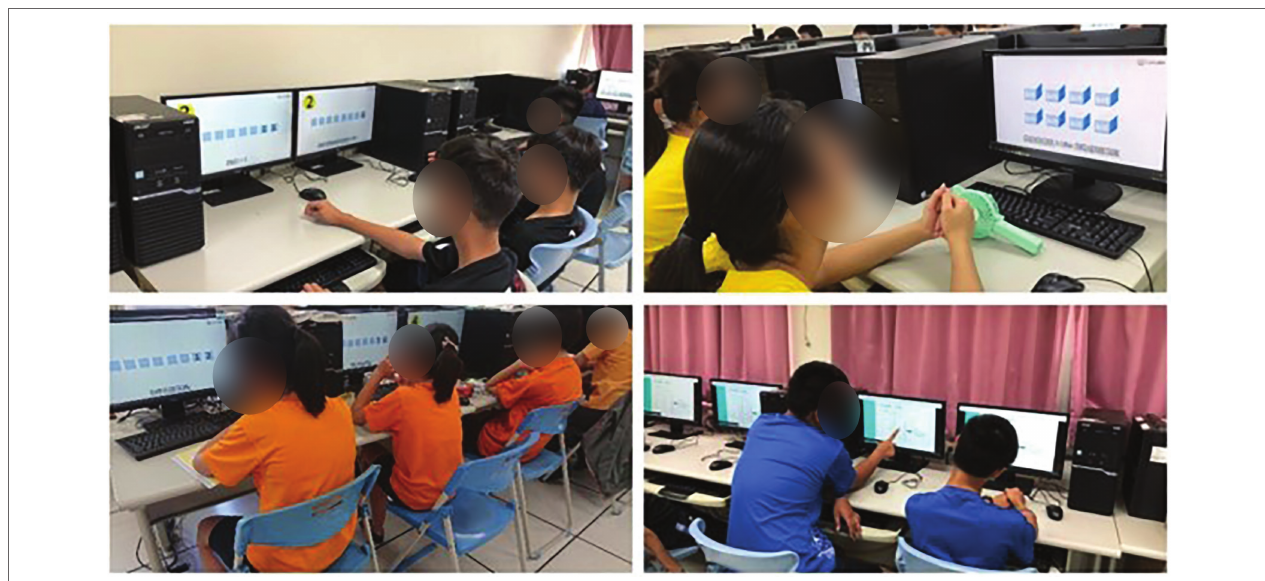
FIGURE 4 | Learning activities for